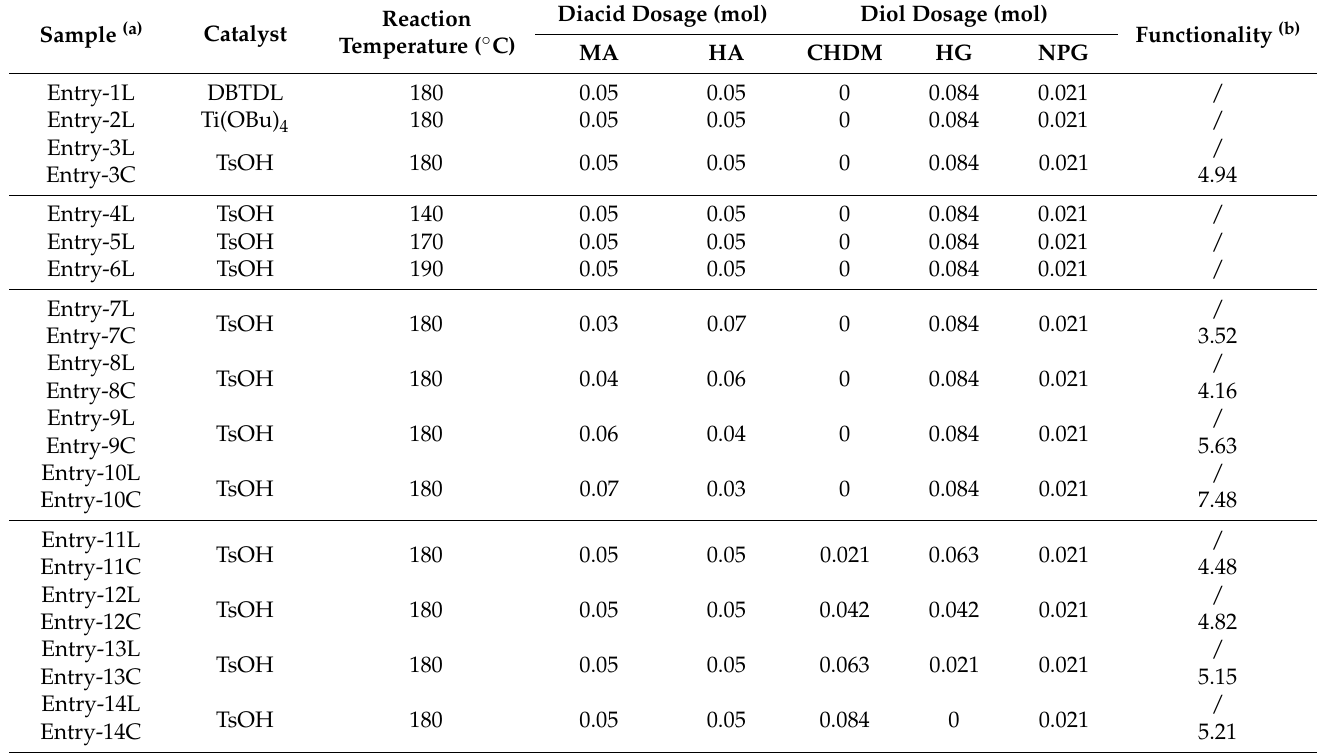
Table 1. The formulation and synthesis condition of